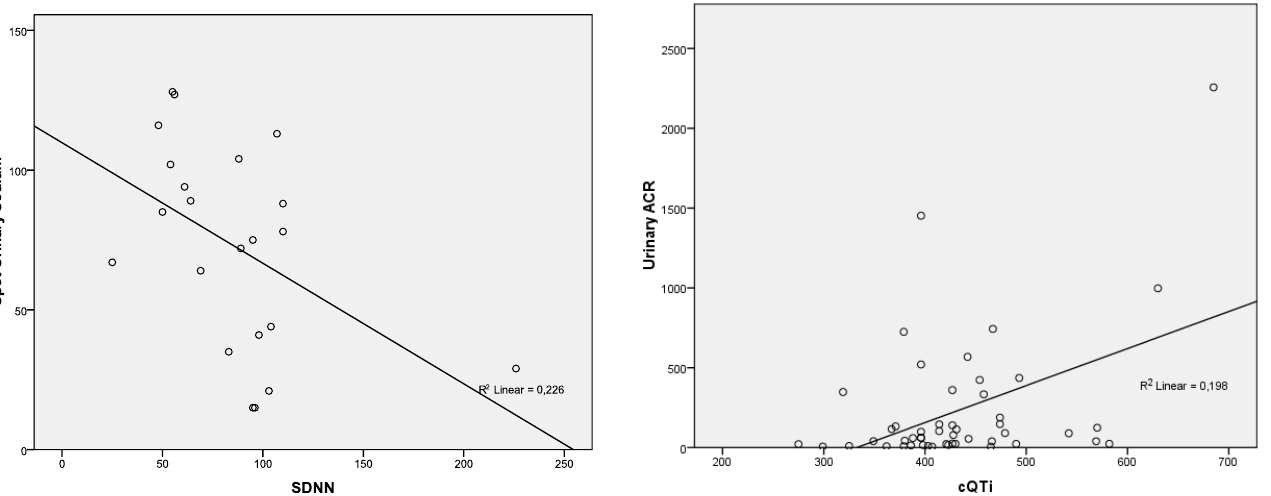
Figure 4. Correlations of spot urinary sodium and SDNN. Correlations of urinary ACR and cQTi in patients with AHF. Abbreviations: SDNN = standard deviation of the NN intervals; cQTi = corrected QT interval; ACR = albumin to creatinine ratio.